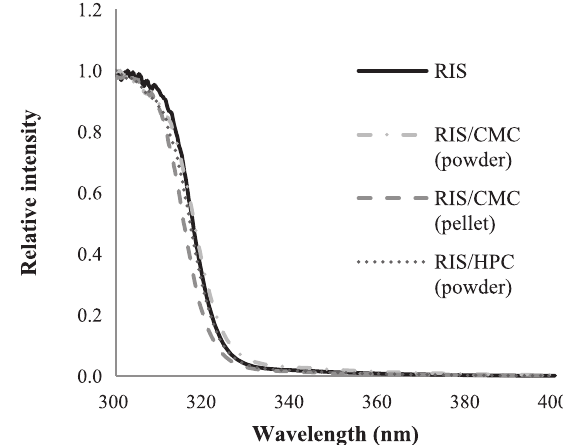
Fig. 2 Solid-state UV-VIS spectra of risperidone and samples a)~c).